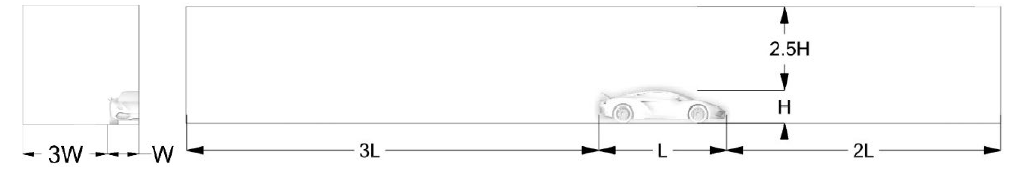
Figure 7. Size of the computational domain with length L = 4.6 m, height H = 1.1 m, and width W = 1.1 m.